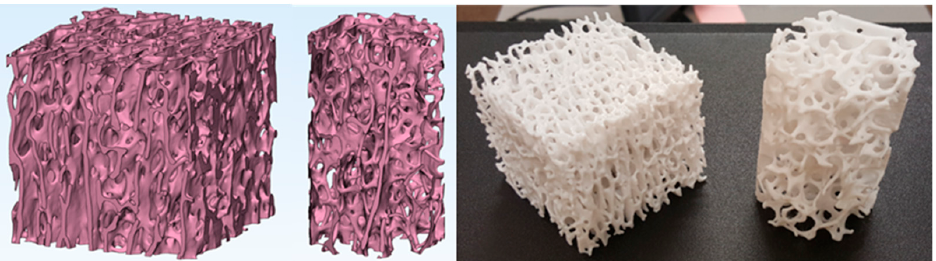
Figure 6. Micro-CT segmented 3D models of cubic bone sample CU#1 and Cylindrical sample CY#1 ( left ) and 3-D printed model using additive manufacturing technique ( right ).